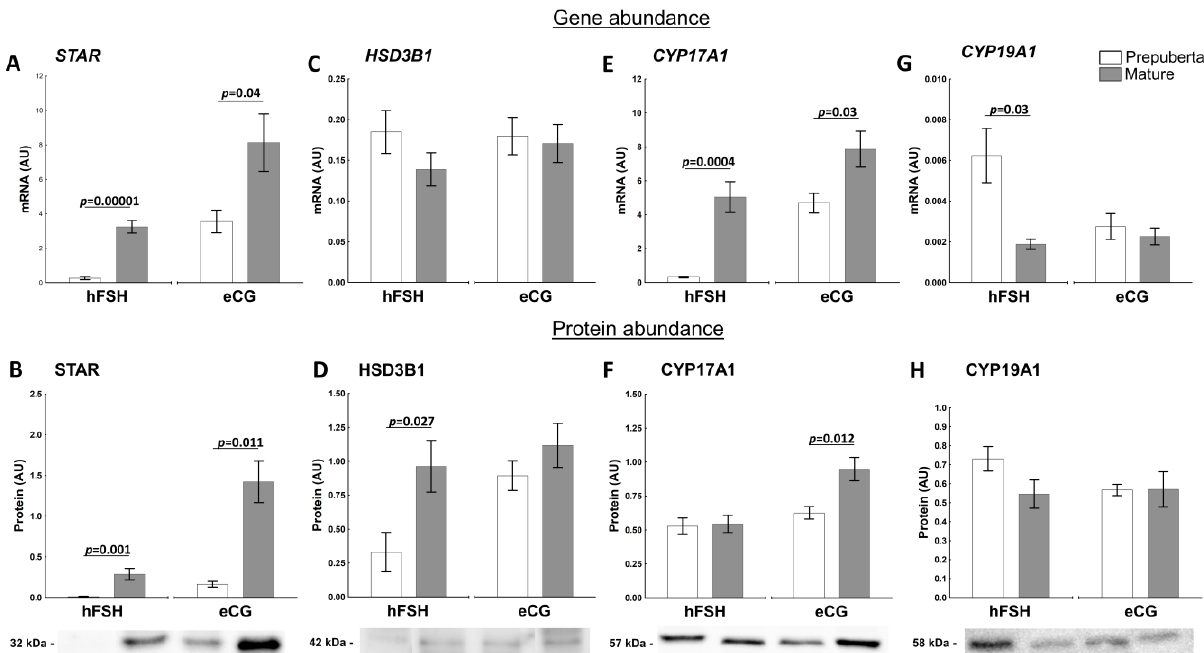
Figure 3. Sexual maturity status (pre-puberty or maturity) change abundance of factors related to production of androgens and estrogens in ovarian follicles of hFSH- and eCG-primed gilts. The expression of STAR ( A , B ), HSD3B1 ( C , D ), CYP17A1 ( E , F ) and CYP19A1 ( G , H ) in prepubertal and mature gilts was evaluated. Gene expression was normalized to the geometric mean of ACTB and GAPDH (AU), identified as the best reference genes by NormFinder algorithm. Protein levels were normalized to total protein content (AU) using TGX Stain-Free gel technology ( B , D , F , H ). Uncropped blots are presented in Supplementary Figure S1. Data were analyzed using Student’s t -test for each treatment and are presented as mean ± SEM (n = 6 per group). Line with a p -value denotes significant differences between prepubertal and mature gilts. AU — arbitrary units.